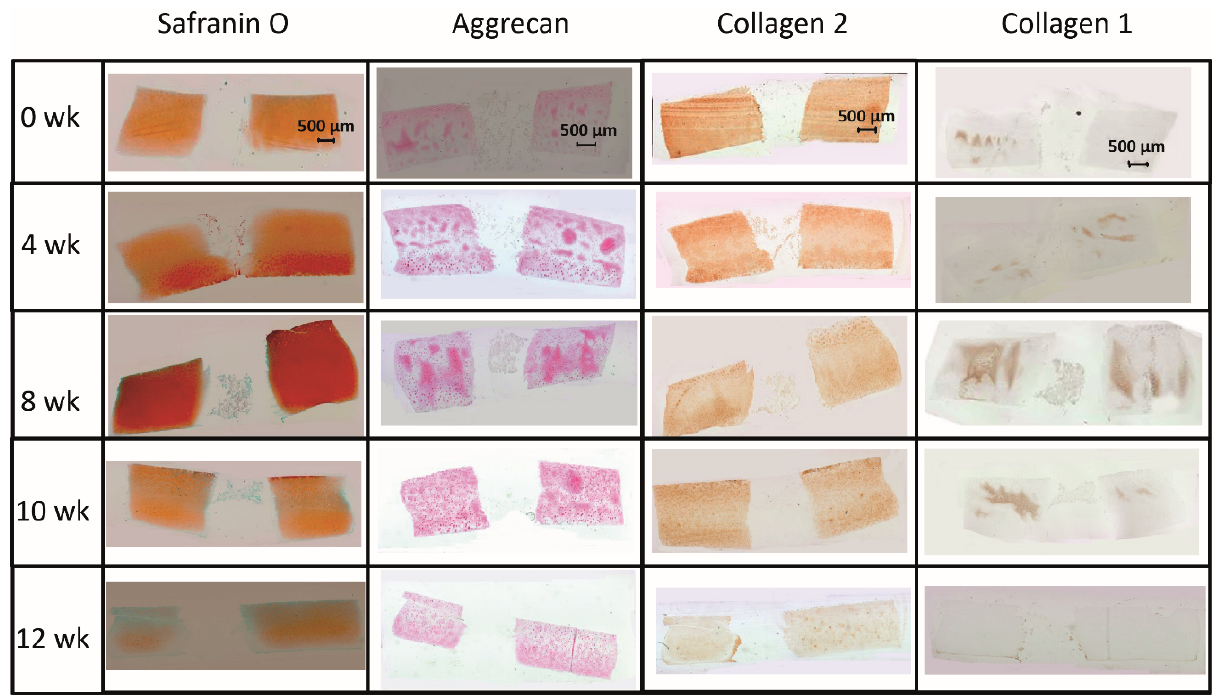
Figure 2. (Immuno)staining of PGA (cell-free) during in vitro culture.